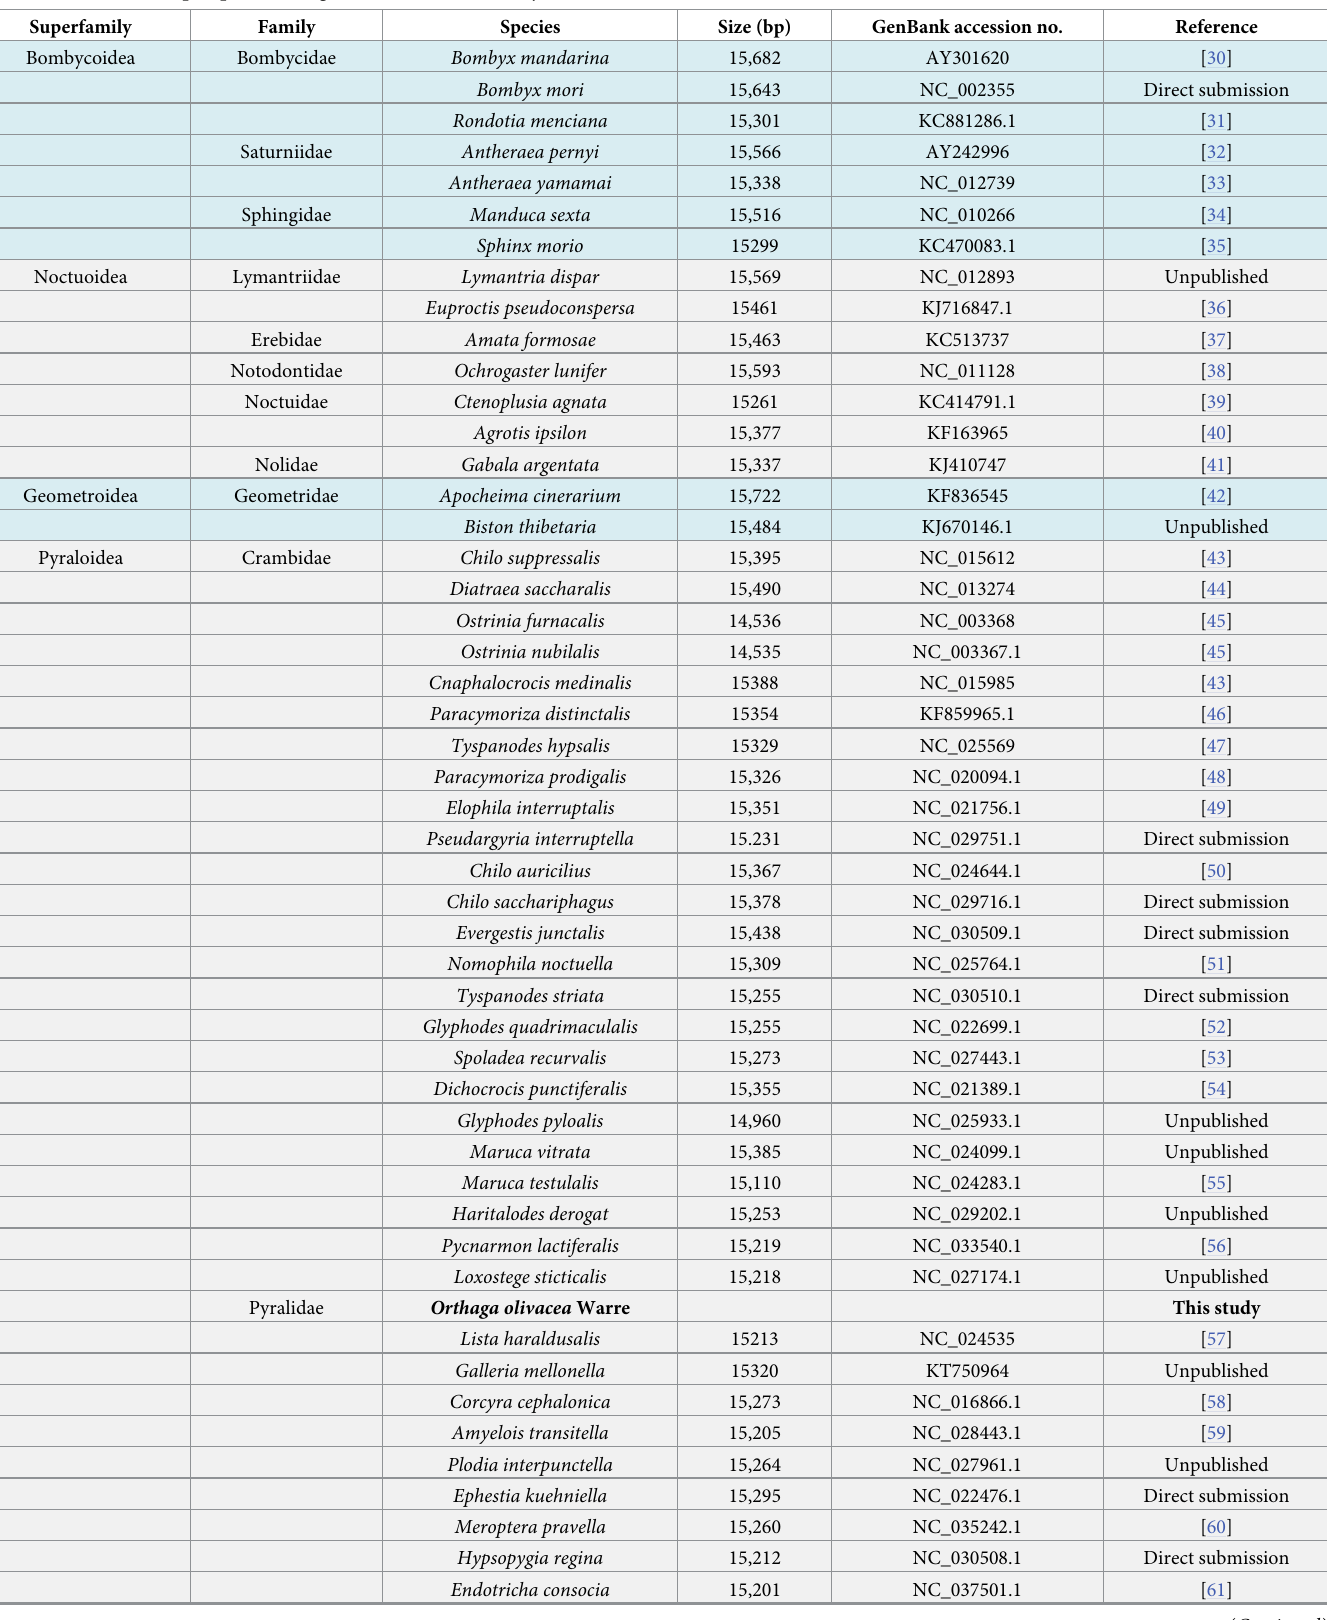
Table 2. Details of the lepidopteran mitogenomes used in this study.